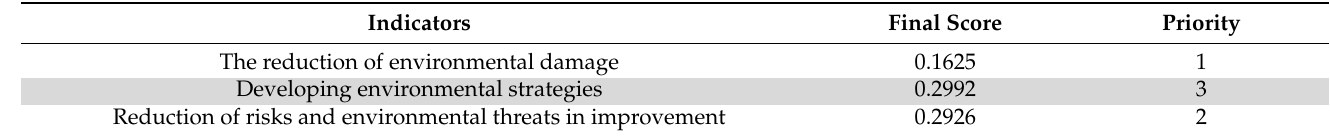
Table 19. Priority related to attention to commitment to environmental assessment indicators.